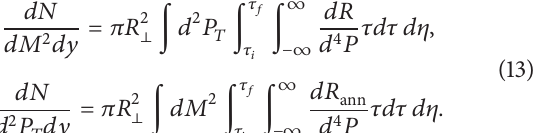
+ 𝑙 − 𝑞𝑞 is the total cross-sec-